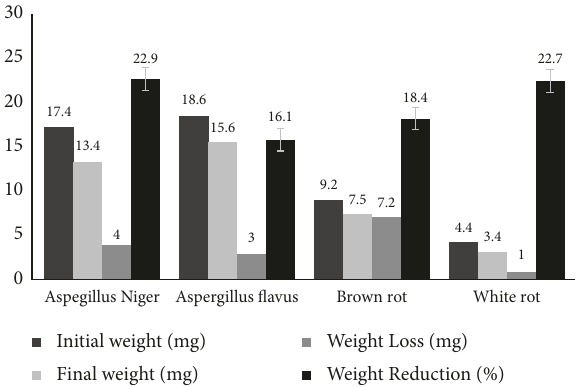
Figure 3: Graphical representation of percentage weight loss of plastic samples after treating with fungal isolates.